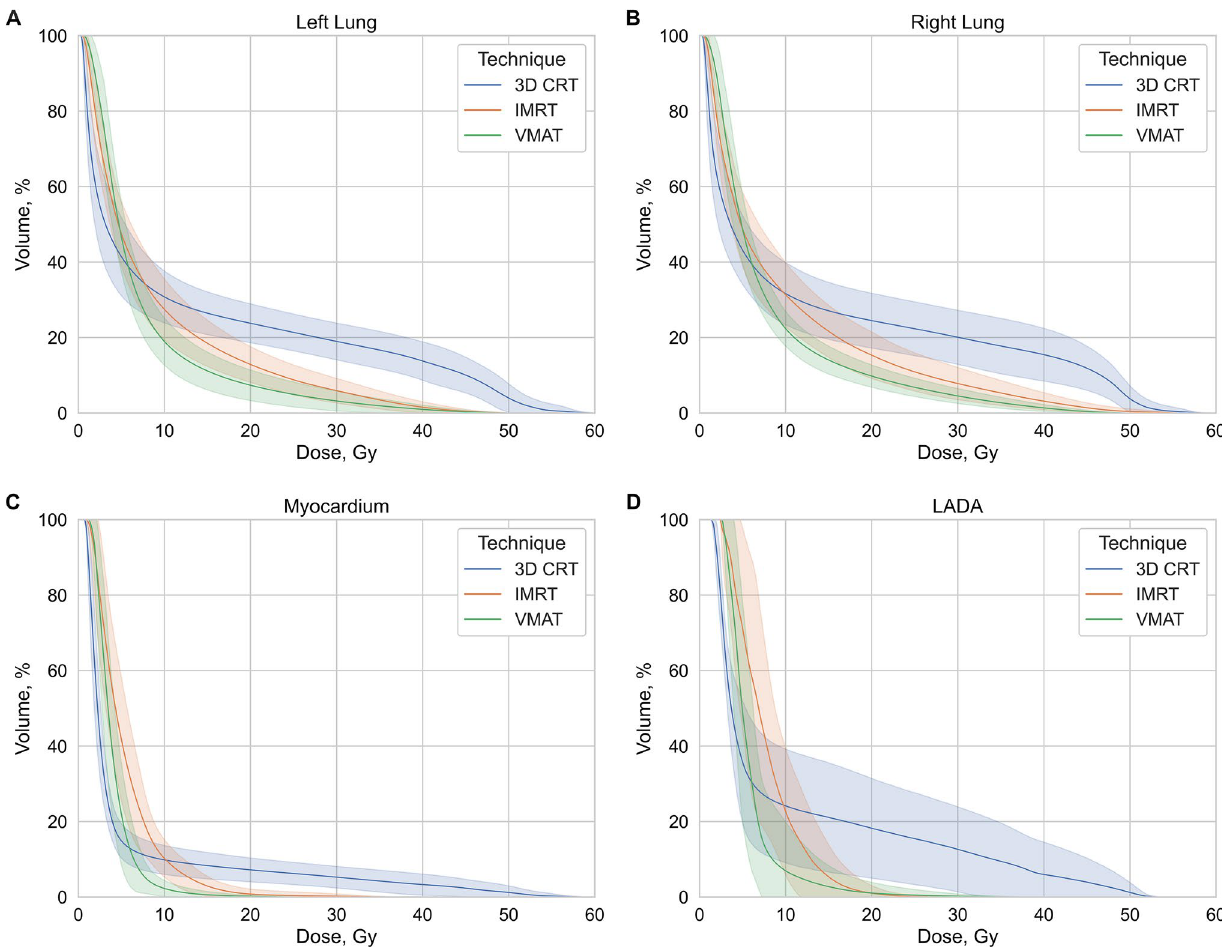
Fig. 2 Comparison of DVHs between three radiation therapy techniques for left lung ( A ), for right lung ( B ), for myocardium ( C ) and for LADA ( D ). The blue line represents 3D CRT method, the red line—IMRT, the green line—VMAT. Colored shadows designate